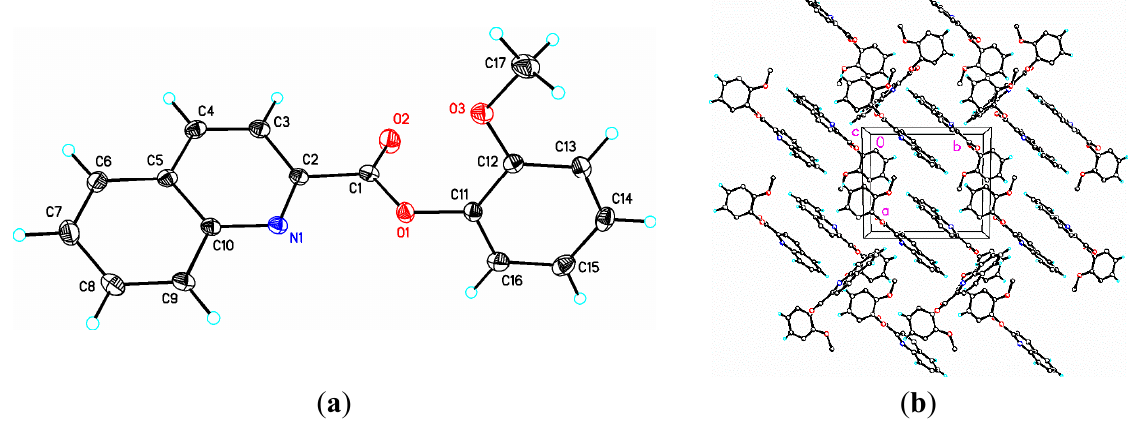
Figure 3. ( a ) Molecular structure of C 17 H 13 NO 3 , ( II ), showing the atom numbering scheme with 30% probability ellipsoids; ( b ) Packing diagram for (II) viewed along the c axis. H atoms not involved in hydrogen bonding have been removed for